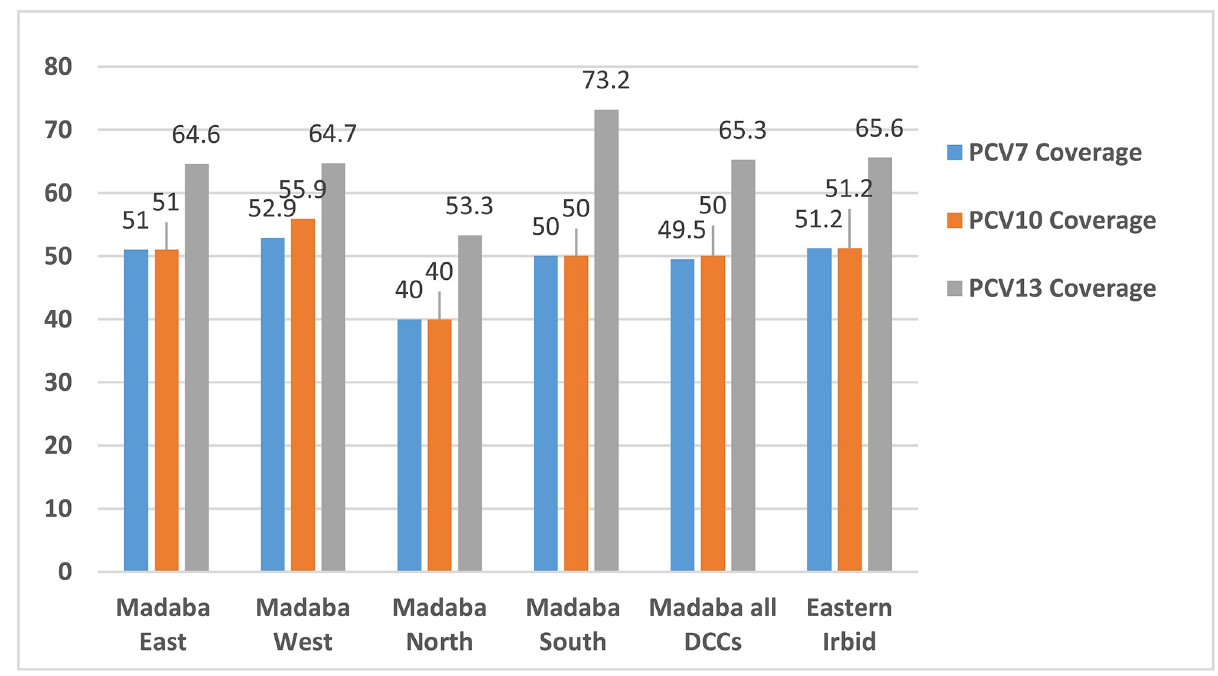
Fig 4. Coverage of the pneumococcal conjugate vaccines in each DCC for both winter seasons from October 2017-end of March 2019.